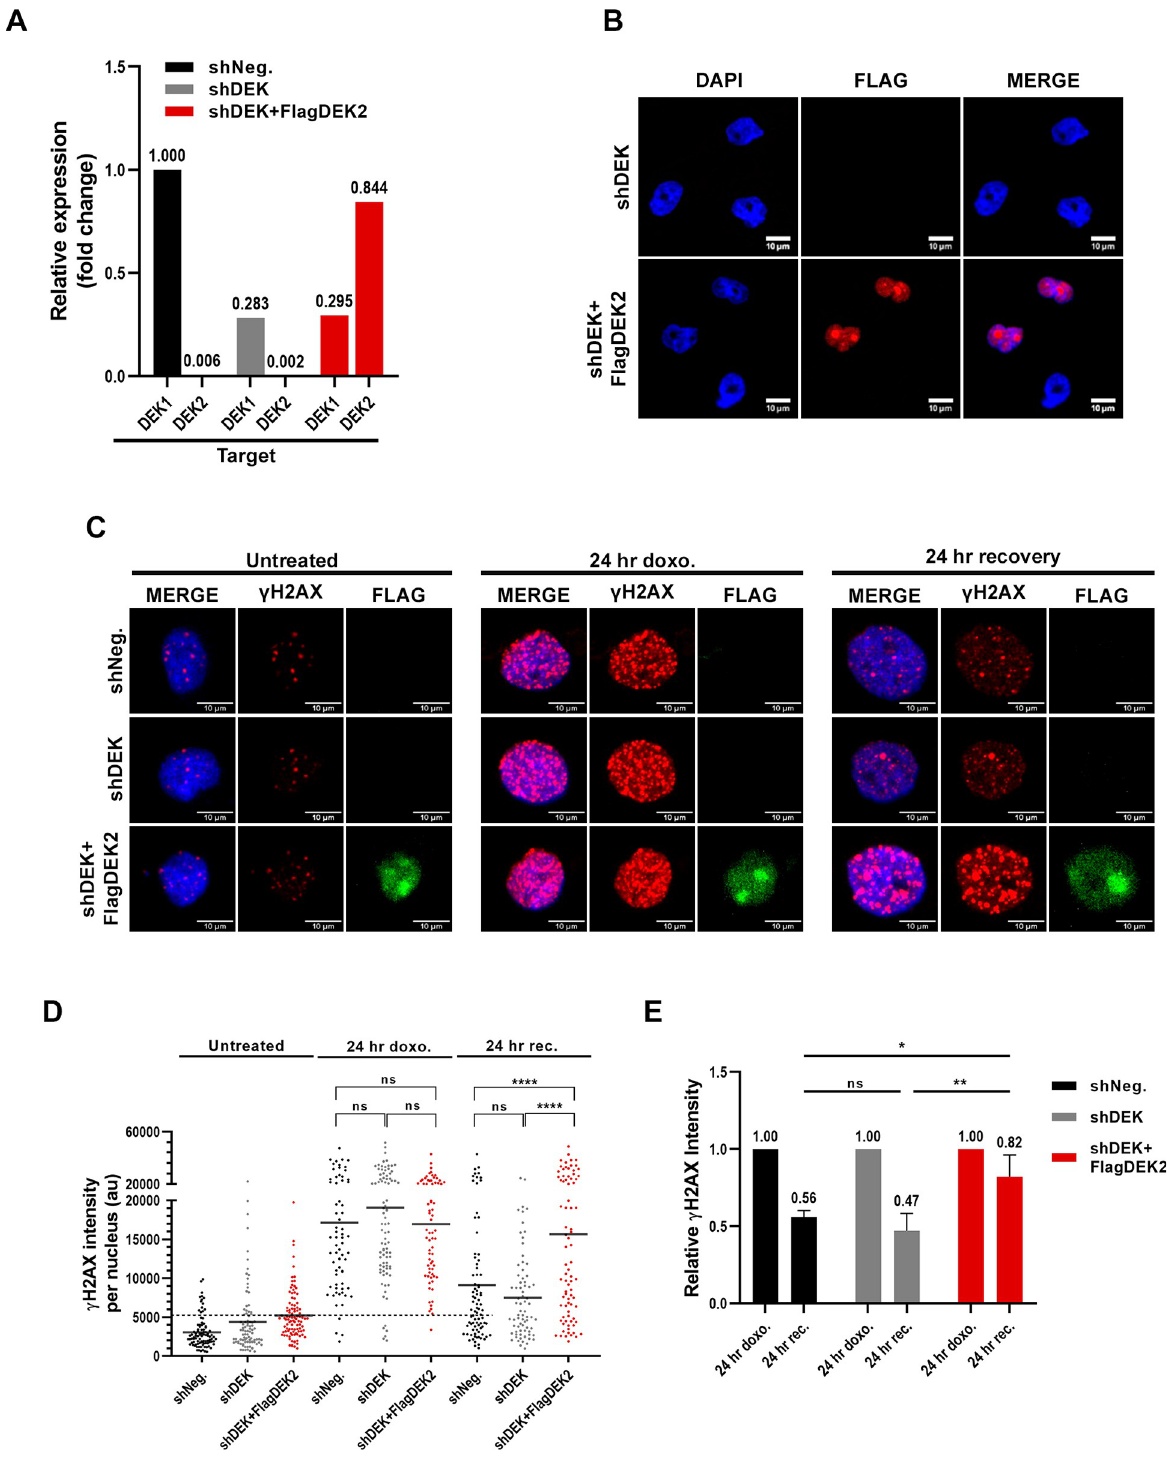
Fig 4. DEK2 does not compensate lack of DEK1. (A) RT-qPCR analysis showing DEK knockdown efficiency. Primer sets specific to DEK1 or DEK2 (X-axis, target) were used to determine the expression level of each isoform. Relative expression was calculated using the DEK1 expression level in the control HS-27A cells (GFP only) as a calibrator. (B) Confocal pictures of immunofluorescence staining with anti-Flag antibody showing ectopic FlagDEK2 expression in the shDEK+FlagDEK2 cells (mid-low panel, red). DAPI labels the nucleus (blue) (40X, with oil). (C) Representative confocal pictures of double immunocytochemistry analysis showing staining with anti- γ H2AX (red) and anti-Flag (green)